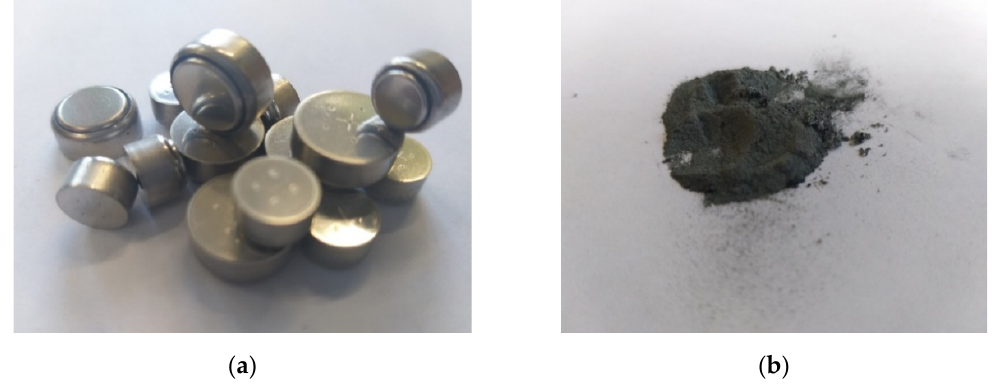
Figure 2. The button cell batteries ( a ) and used battery powder ( b ).